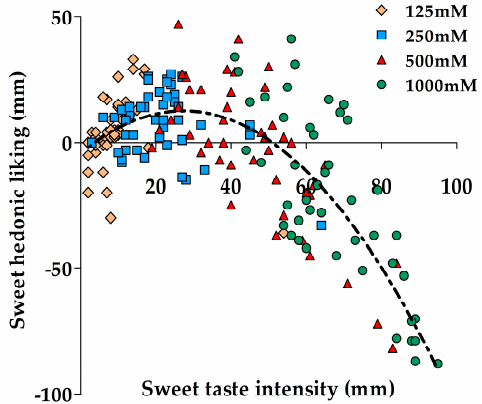
Figure 2. Scatterplot of the relationship between sweet taste intensity and hedonic liking. The scatterplot was generated using the average sweet taste intensity and hedonic liking ratings across the four repeated sessions. n = 44.